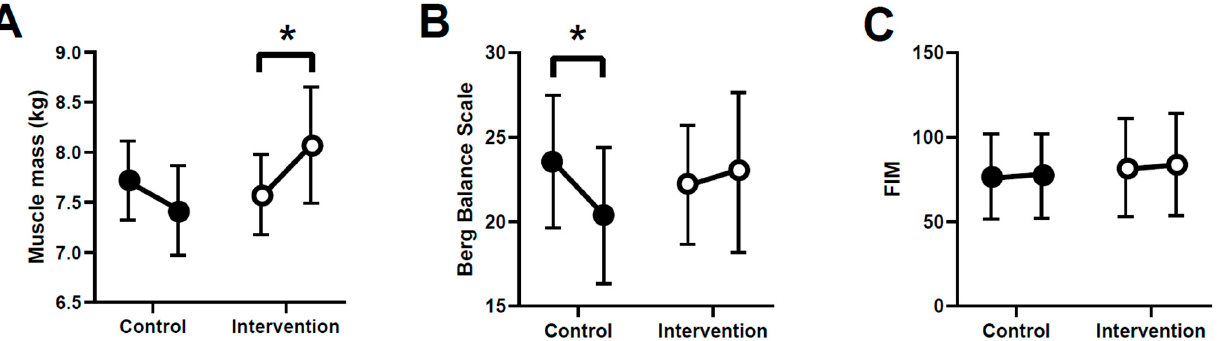
Figure 2. Comparison of muscle mass ( A ), Berg Balance Scale (BBS) score ( B ), and FIM score ( C ) pre- and postintervention in the two groups. * p < 0.05. Data shown means ± standard error of the mean.